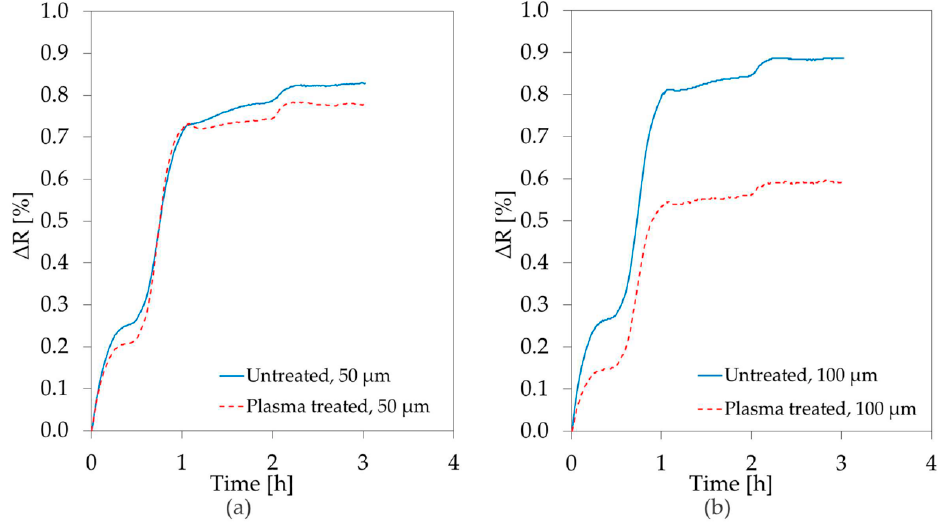
Figure 6. Percentage change, over 3 h, in the resistance of ( a ) 50 µm; and ( b ) 100 µm, wide Cu track exposed to saline solution 0.9% at 37 °C through a protective layer of 5 µm of Parylene-C.